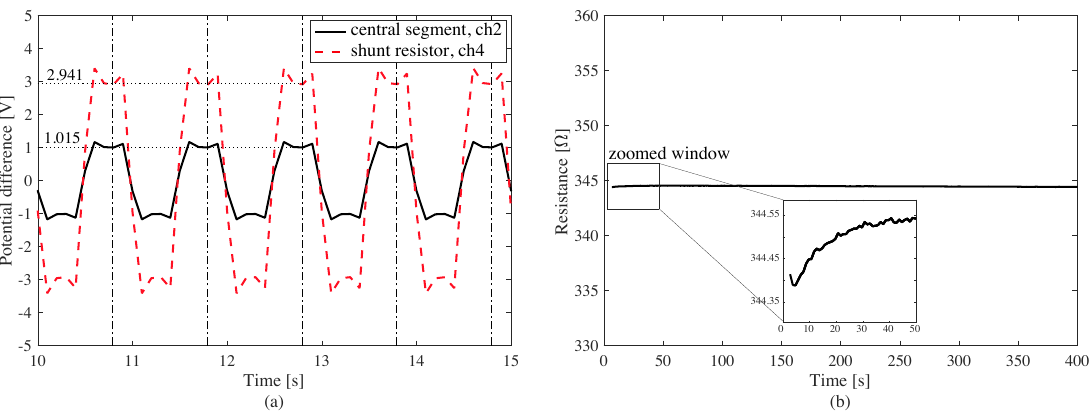
Figure 10. Plate response to the unloaded polarization test: ( a ) time window of raw voltage reading from ch4 (shunt resistor) and ch2 (central segment); ( b ) resistance time history of the central segment of the plate with a zoom on the first 50 s of the